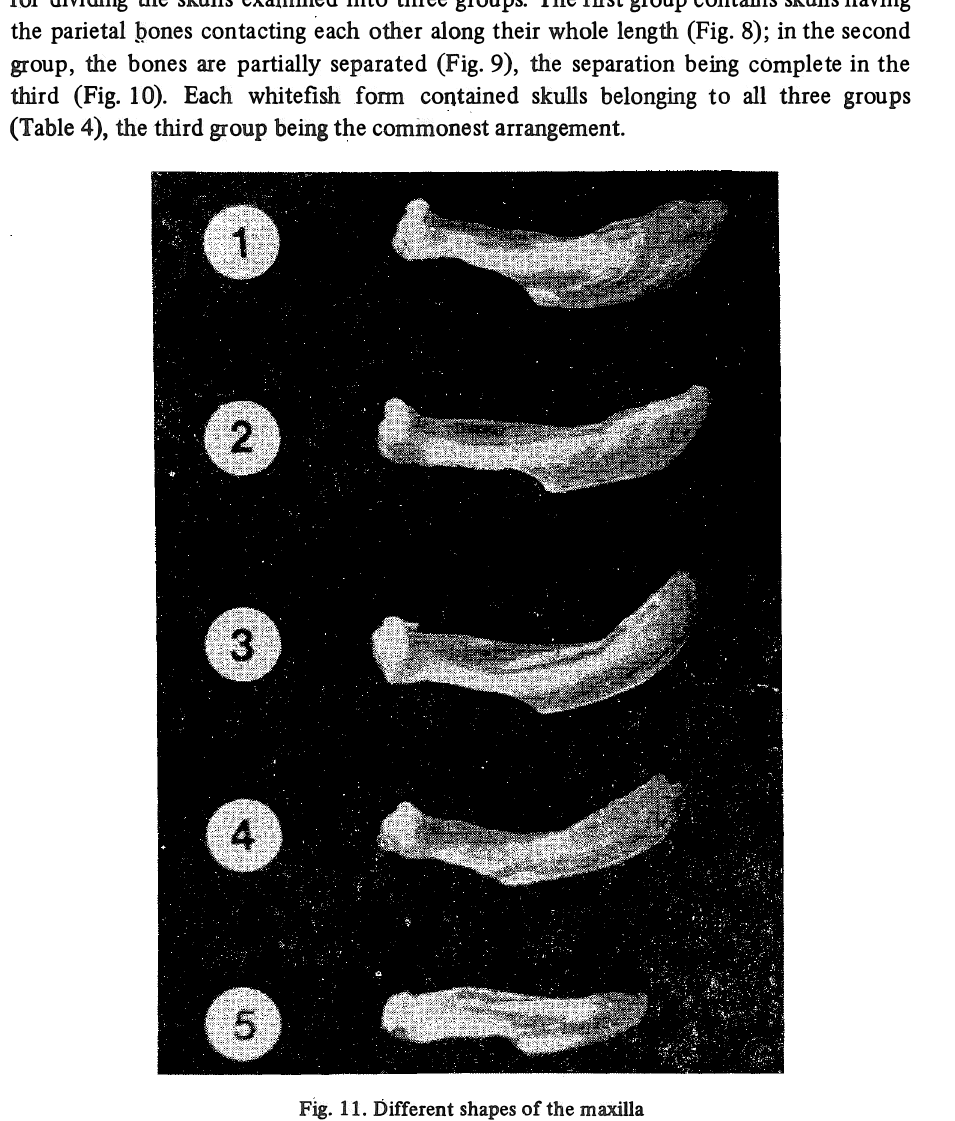
Fig. 11. Different shapes of the